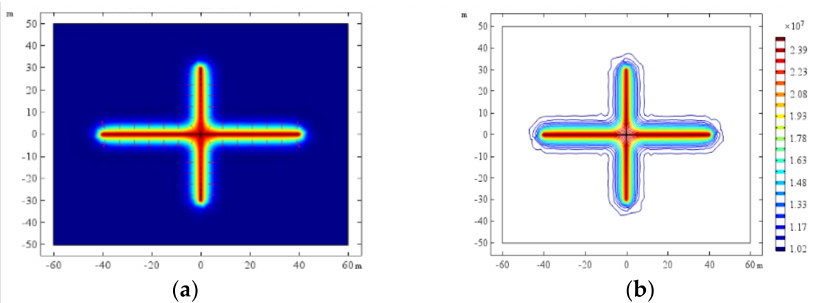
Figure 6. Case 3 calculation result. ( a ) Grout propagation pattern. ( b ) Distribution of grout propaga- tion pressure field.